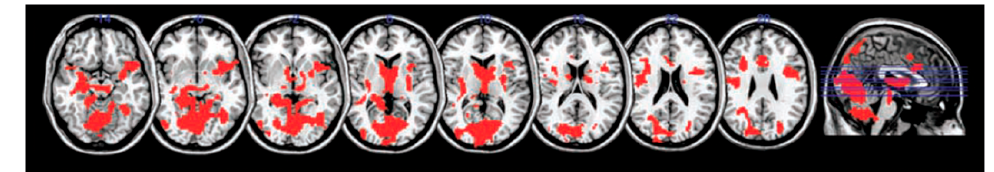
Figure 3. SPM analyses identified hyperactivity (warm colours) during accurate delayed verbal memory recognition in Ch+ breast cancer survivors compared to healthy control. Adapted from Kesler et al. [111].